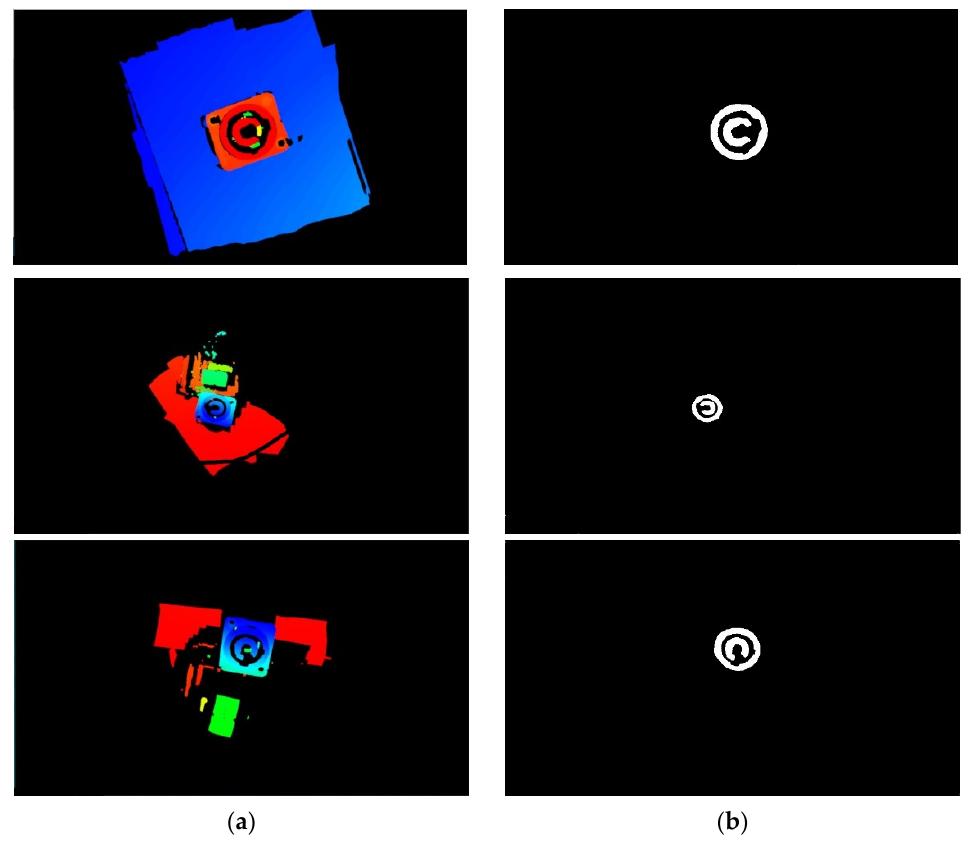
Figure 18. Neutrik plug depth image andsegmented image: ( a ) Neutrik plug depth image; ( b ) segmented image.